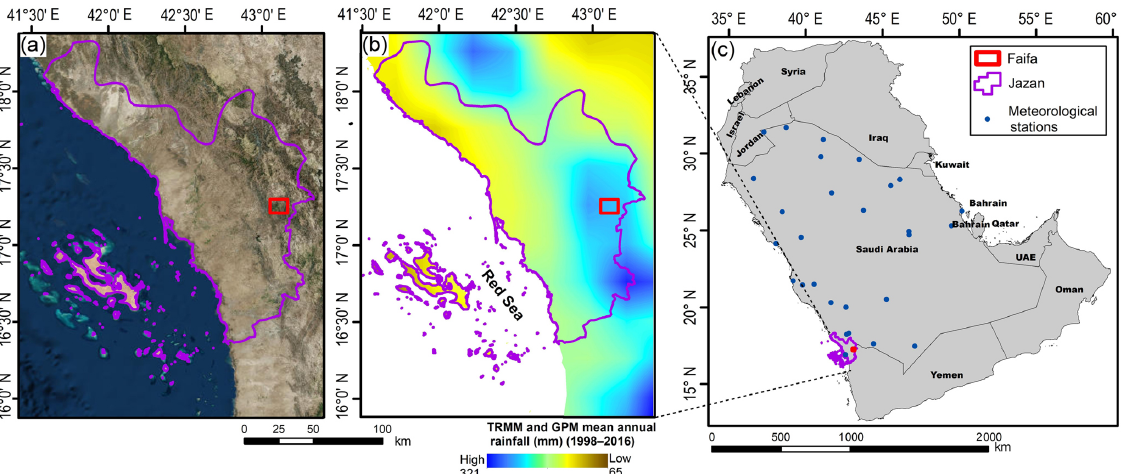
Figure 1. Location of the study area. (a) Faifa Mountains within the Jazan Province. (b) Mean annual precipitation (MAP; 1998–2016) ex- tracted from TRMM (1998–2014, 3B43 level-3, monthly, spatial resolution: 0 . 25 ◦ × 0 . 25 ◦ ) and GPM (2014–2016, IMERG level-3, monthly, spatial resolution: 0 . 1 ◦ × 0 . 1 ◦ ) showing the higher regional rainfall around the Faifa Mountains (MAP in Faifa: 252mmyr − 1 ) in the southeast part of the Jazan Province. (c) Distribution map of the meteorological stations in the Arabian Peninsula (Mashat and Basset, 2011) in Saudi